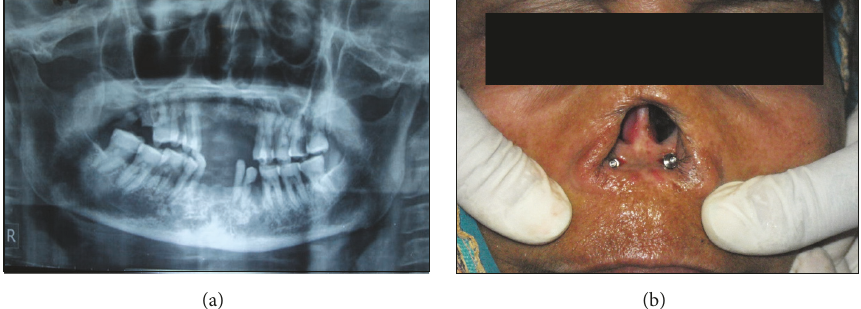
Figure 2: (a) Preoperative panoramic radiograph showing partially edentulous maxillary and mandibular arches. (b) Patient’s face with O- ring post over implants in anterior nasal floor.